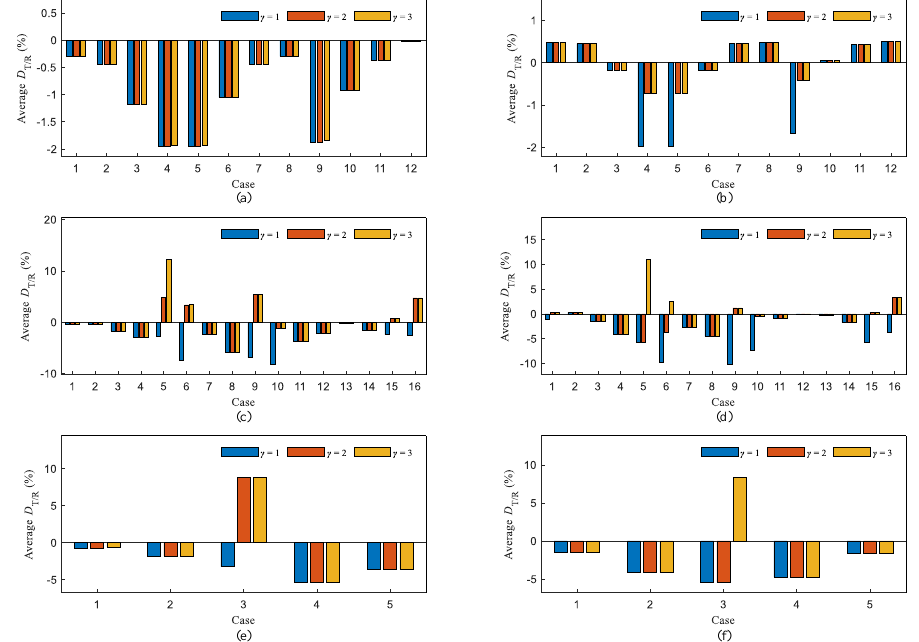
Figure 4. Given an exponent γ of ESR = 1, 2, or 3, the average target deviations for cases in three types of numerical experiments were as shown above; ( a , b ) contains cases for the first type without and with maximum area limitations; ( c , d ) contains cases for the second type without and with maximum area limitations; ( e , f ) contains cases for the third type without and with maximum area limitations.